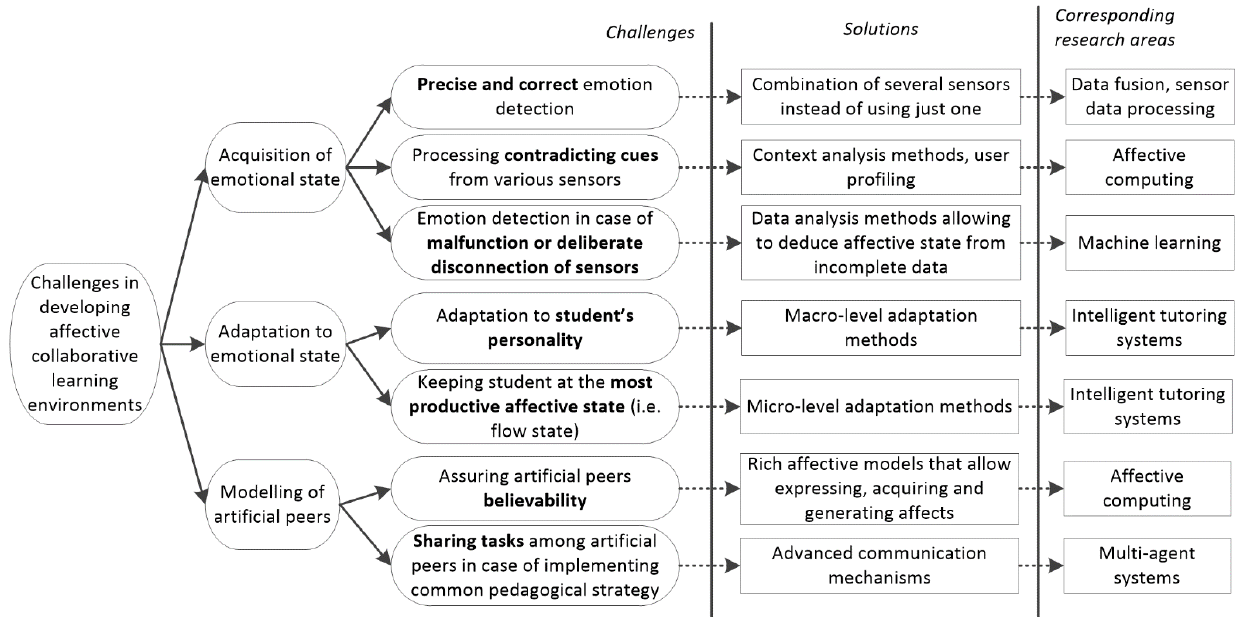
Fig. 2. Identified challenges, solutions and corresponding research